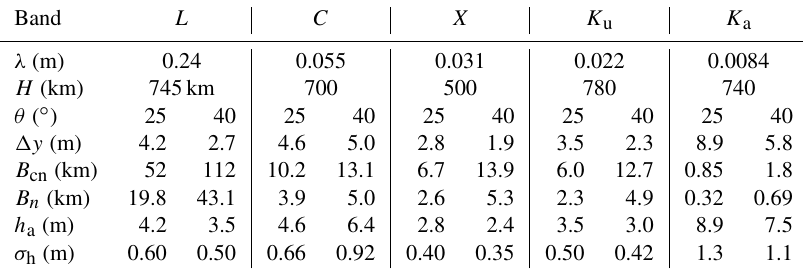
Table 1. Ambiguity heights h a and relative height errors σ h (rounded values) for optimal baselines B n , determined for different satellite configurations ( λ – radar wavelength; H – orbit height; θ – radar incidence angle; (cid:49)y – ground range resolution; B cn – critical baseline). It is assumed that p = 1, N L = 1, and γ N ≈ 1 in Eqs. 2, 4, and 8.